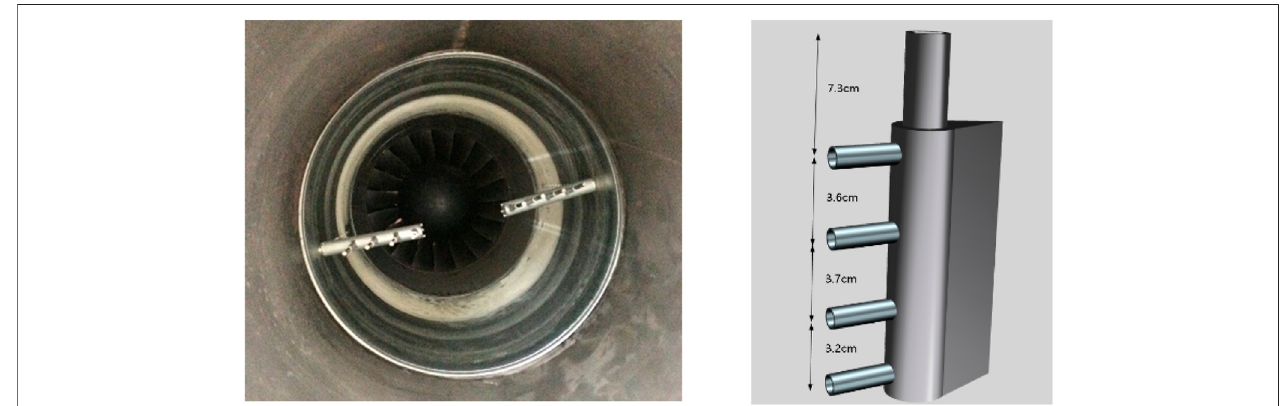
FIGURE 12 | Photo and 3D design drawing of radial rakes.